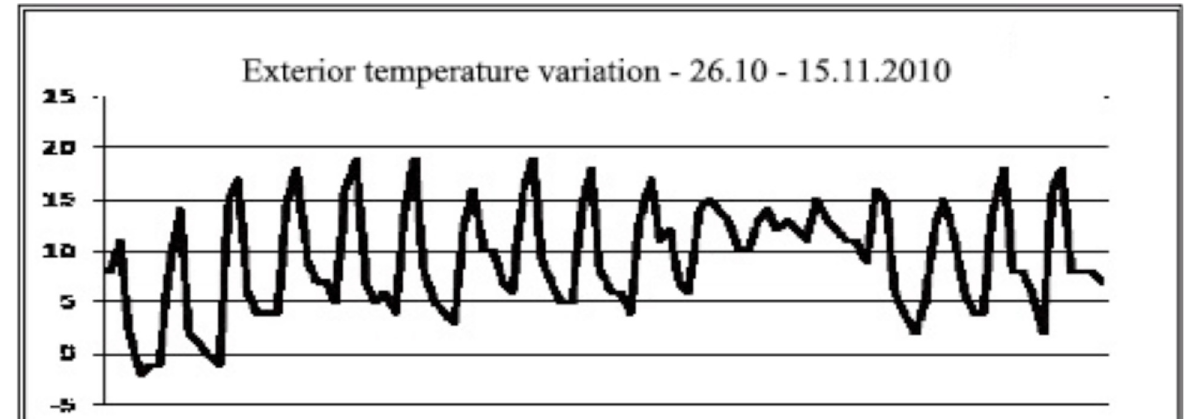
Fig. 7. Exterior temperature variations.